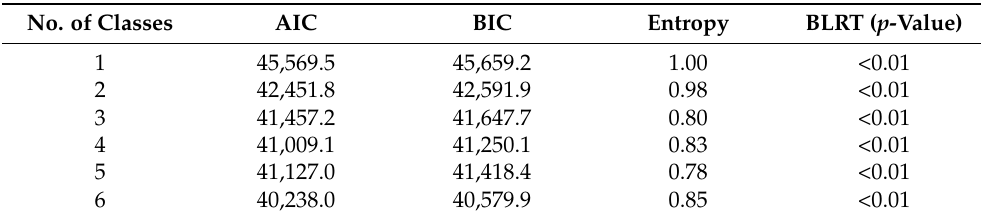
Table 2. Summary of information for selecting the number of latent classes for the latent profile analysis.